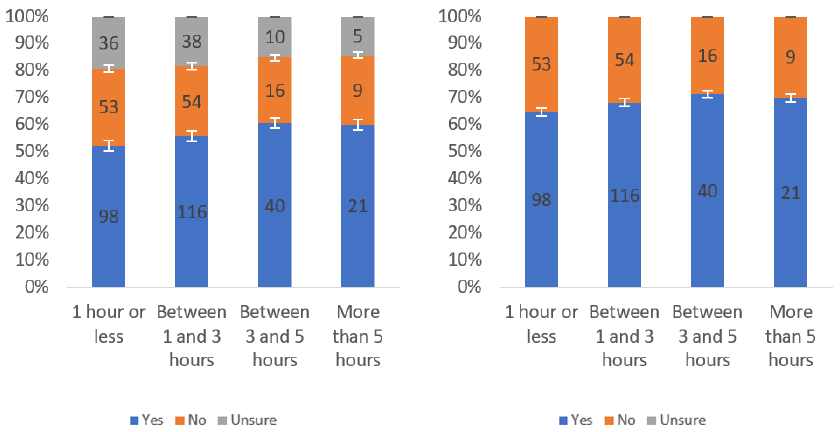
Figure A45. Responses regarding usefulness in judging trustworthiness by internet usage level including ( left ) and excluding ( right ) unsure responses.